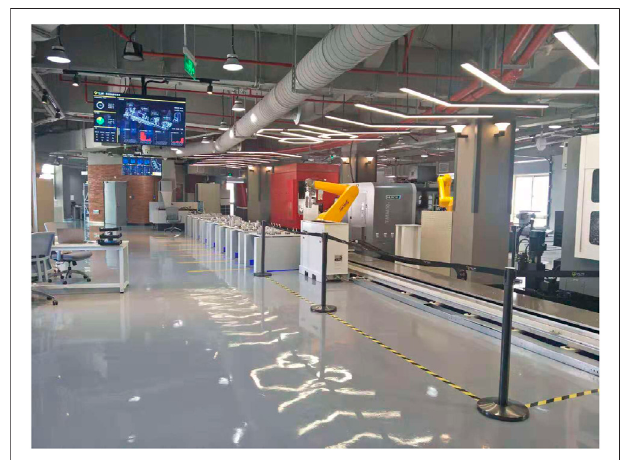
FIGURE 7 | FIRST fl exible manufacturing case (Sang et al.,